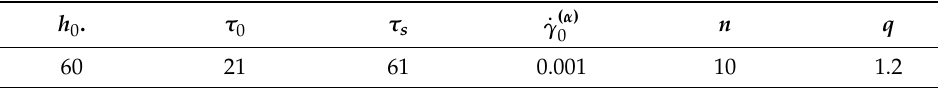
Figure 3. Tensile stress–strain curves by simulation and experiment. Table 1. Constitutive model parameters of pure aluminum. h 0 .